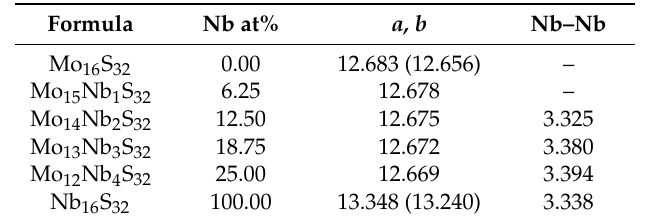
Table 2. Calculated lattice parameters a and b (Å) of the 4 ˆ 4 supercell and dopant closest distances (Å) of the most stable Mo 1 ´ x Nb x S 2 systems. Experimental data are given in parenthesis